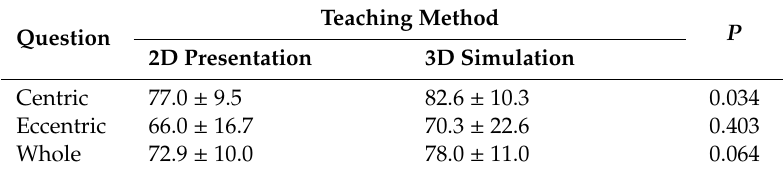
Table 2. Mean and standard deviation of the examination results in groups by different teaching methods.